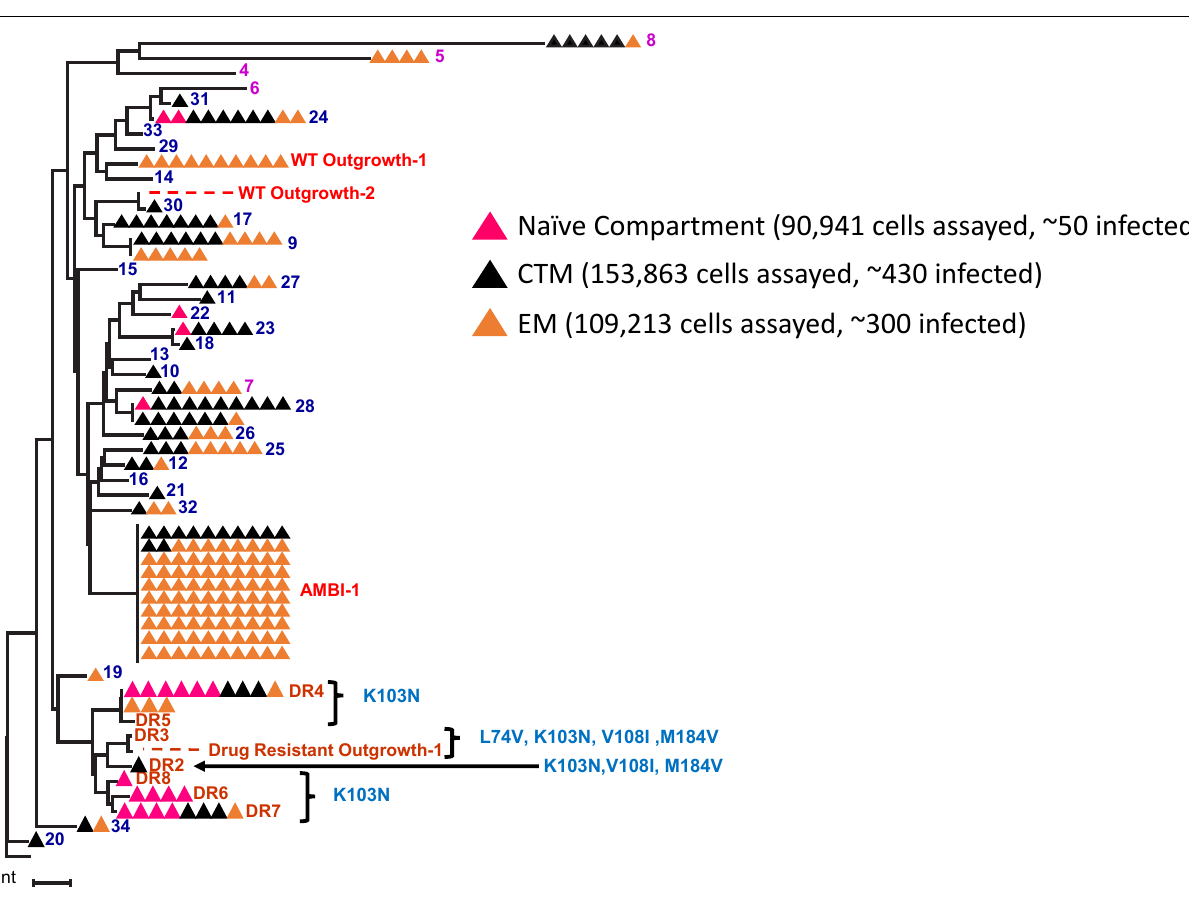
FIGURE 3 | NJ distance tree of proviral sequences from CD4+ T cell memory subsets from the first timepoint (red) in Figure 1 . PBMC were sorted into naïve (pink), central-transitional memory (black), and effector memory (orange) CD4+ T-cell subsets. Possible clones from which ca-HIV RNA was recovered are numbered, including VOA outgrowth viruses. DR mutations are